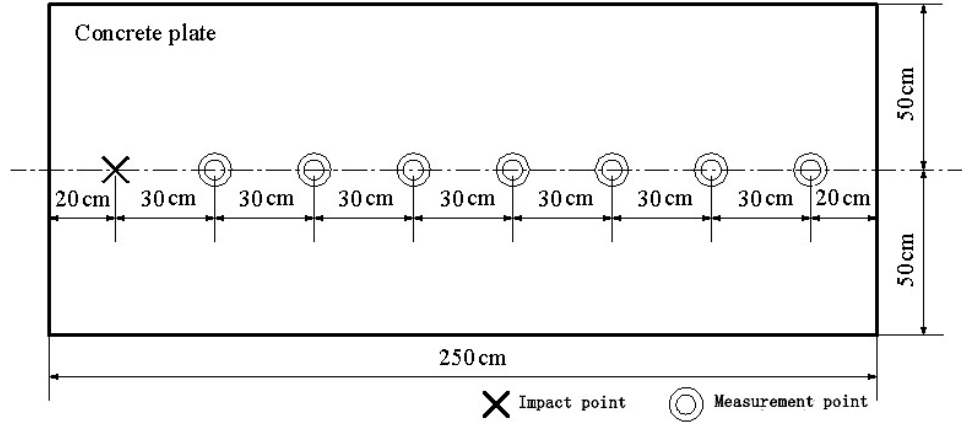
Figure 6. Schematic diagram of measurement point arrangement.